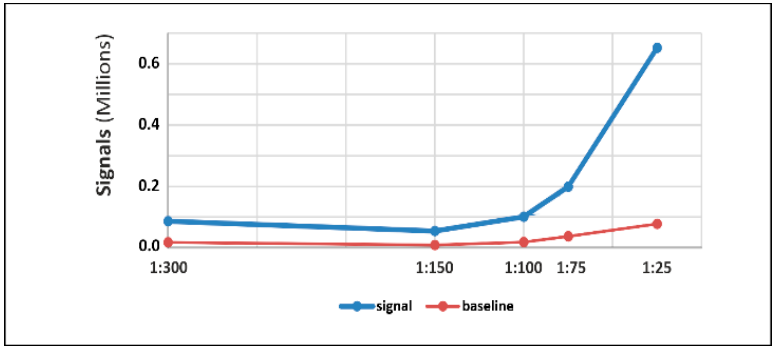
Figure 1. Optimization of anti- β -actin antibodies dilution on capillary western blot: Different dilutions of anti- β -actin (1:25; 1:75; 1:100; 1:150 and 1:300) were used on 0.5 mm 2 LCM section of rat kidney. Signal and baseline, the area under the curve was analyzed to select the best dilution of anti- β -actin antibodies. Dilution 1:75 was selected and used for further experiments.